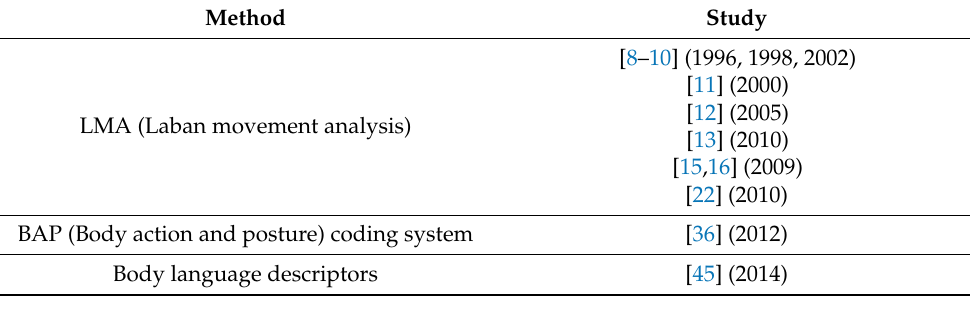
Table 3. Data analysis methods.